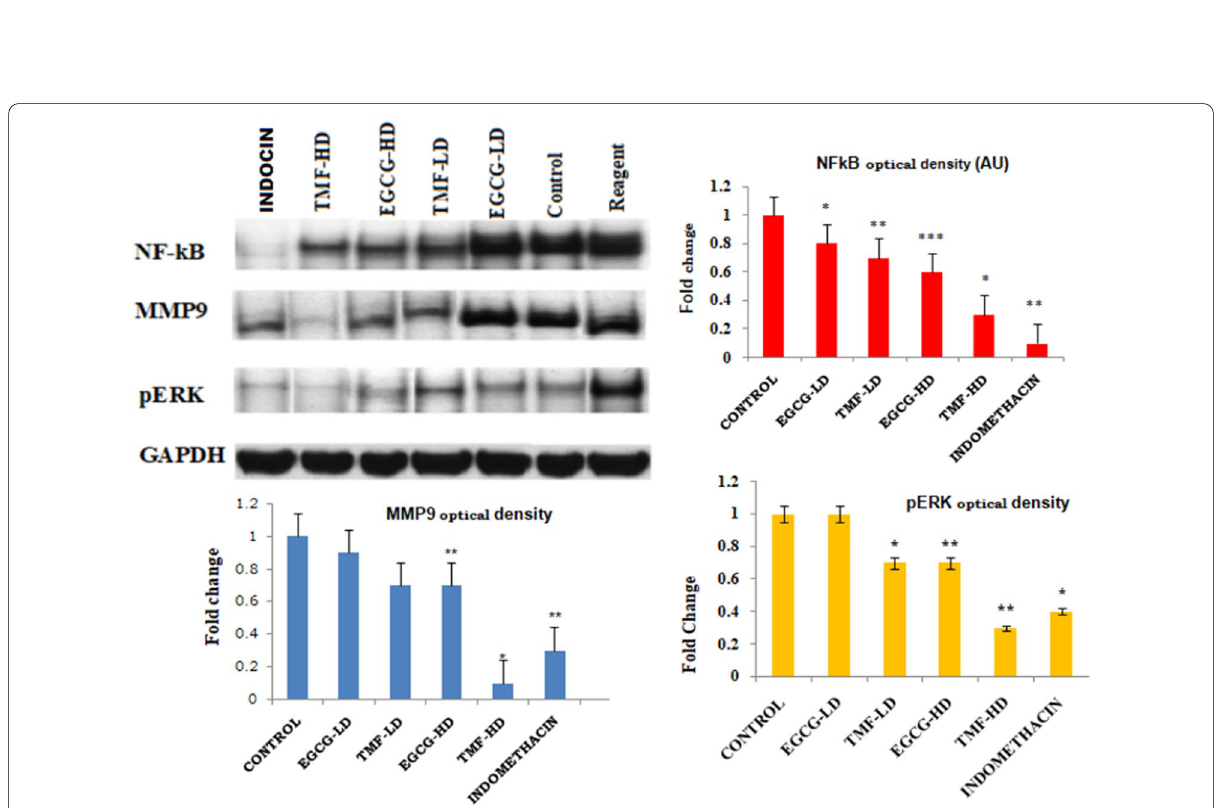
Fig. 7 Immunoblot images of NF-κB, ERK, and MMP9 signaling with their